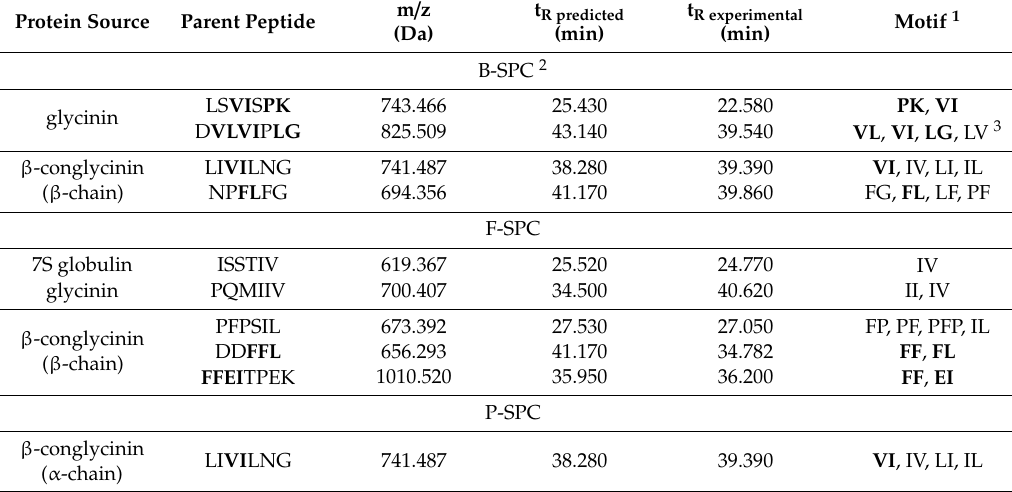
Table 3. Parent peptides identified in SPC hydrolysates using LC-MS / MS (Reversed-Phase High Performance Liquid Chromatography online with tandem Mass